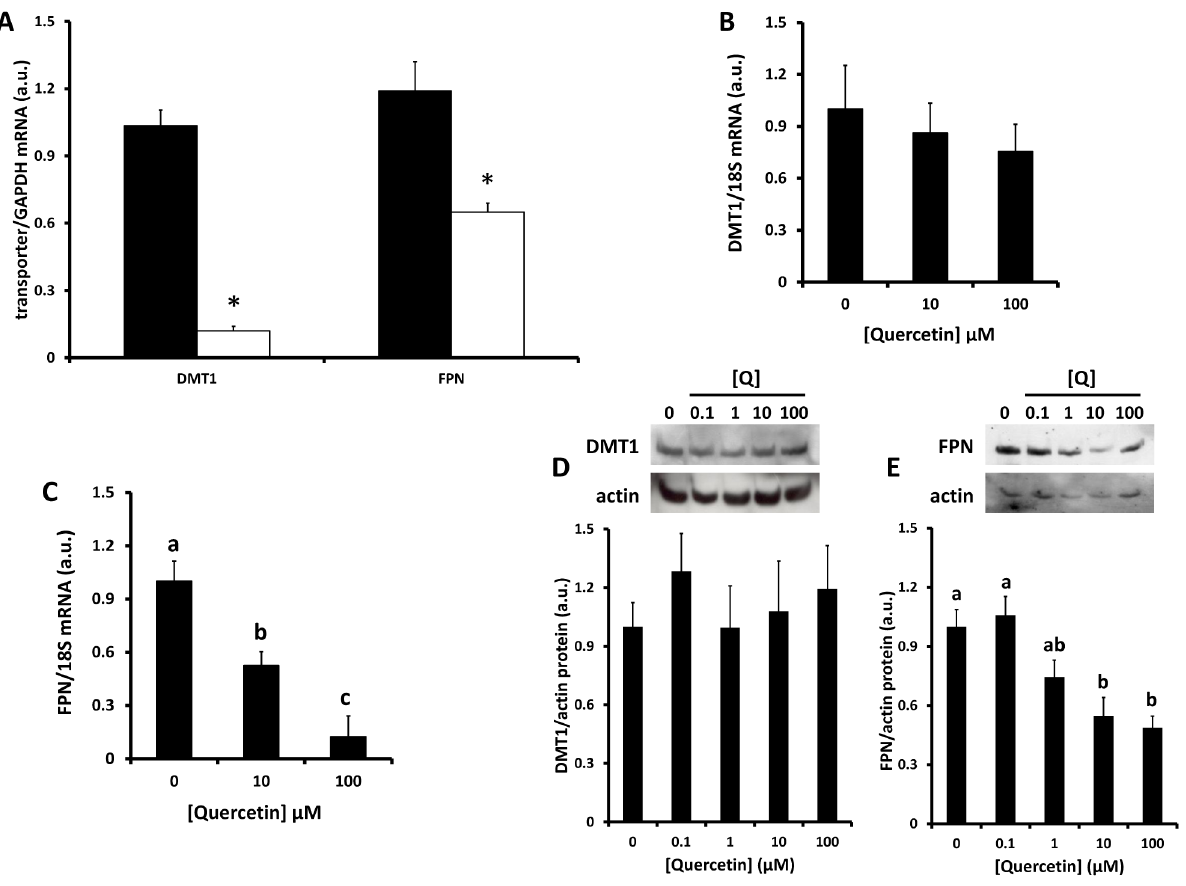
Figure 2. Effects of longer-term exposure to quercetin on intestinal iron transporter expression. Rats (A) were given a single gavage containing quercetin (50 mg/Kg body weight). Caco-2 cells (B & C) were exposed to quercetin (10 or 100 m M). After 18 h RNA was isolated from duodenal tissue (A) and Caco-2 cells (B,C) and used to measure changes in iron transporter mRNA expression. (D,E) Whole cell protein was isolated from Caco-2 cells and used for western blotting to measure DMT1 and FPN protein. Data are mean 6 SEM of 4 (rat duodenum) or 7-18 (Caco-2 cells) observations in each group. (A) *P , 0.05 compared with control group (Student’s unpaired t-test). (B – E) Groups with no common letters are significantly different from each other (one-way ANOVA and Tukey’s post hoc test; P , 0.05). No letters indicates no significant difference between any of the groups.